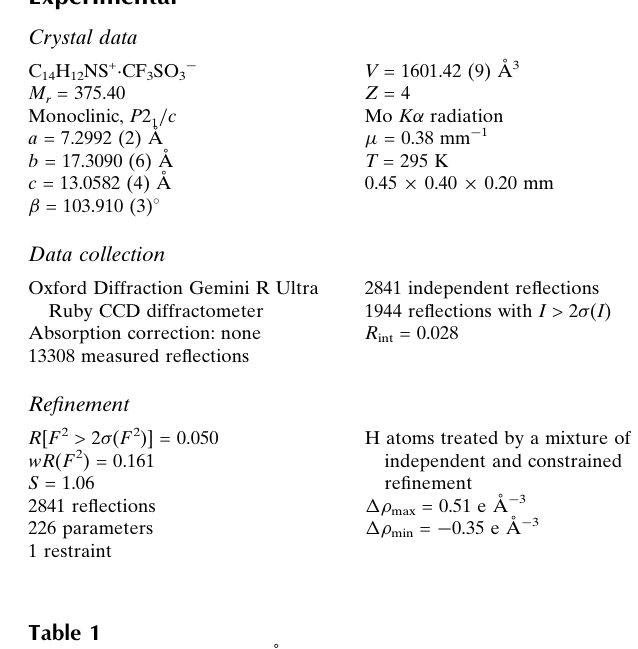
Hydrogen-bond geometry (A˚ , (cid:3) ).